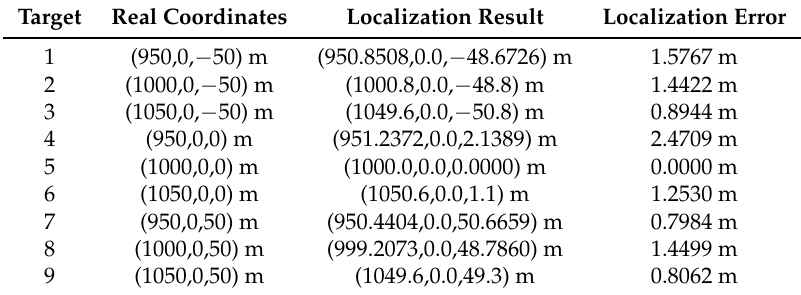
Table 2. Localization results without reference target location error and entropy minimization iteration.